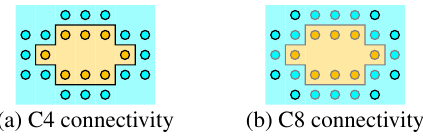
Figure 3. Connectivity impact on perimeter